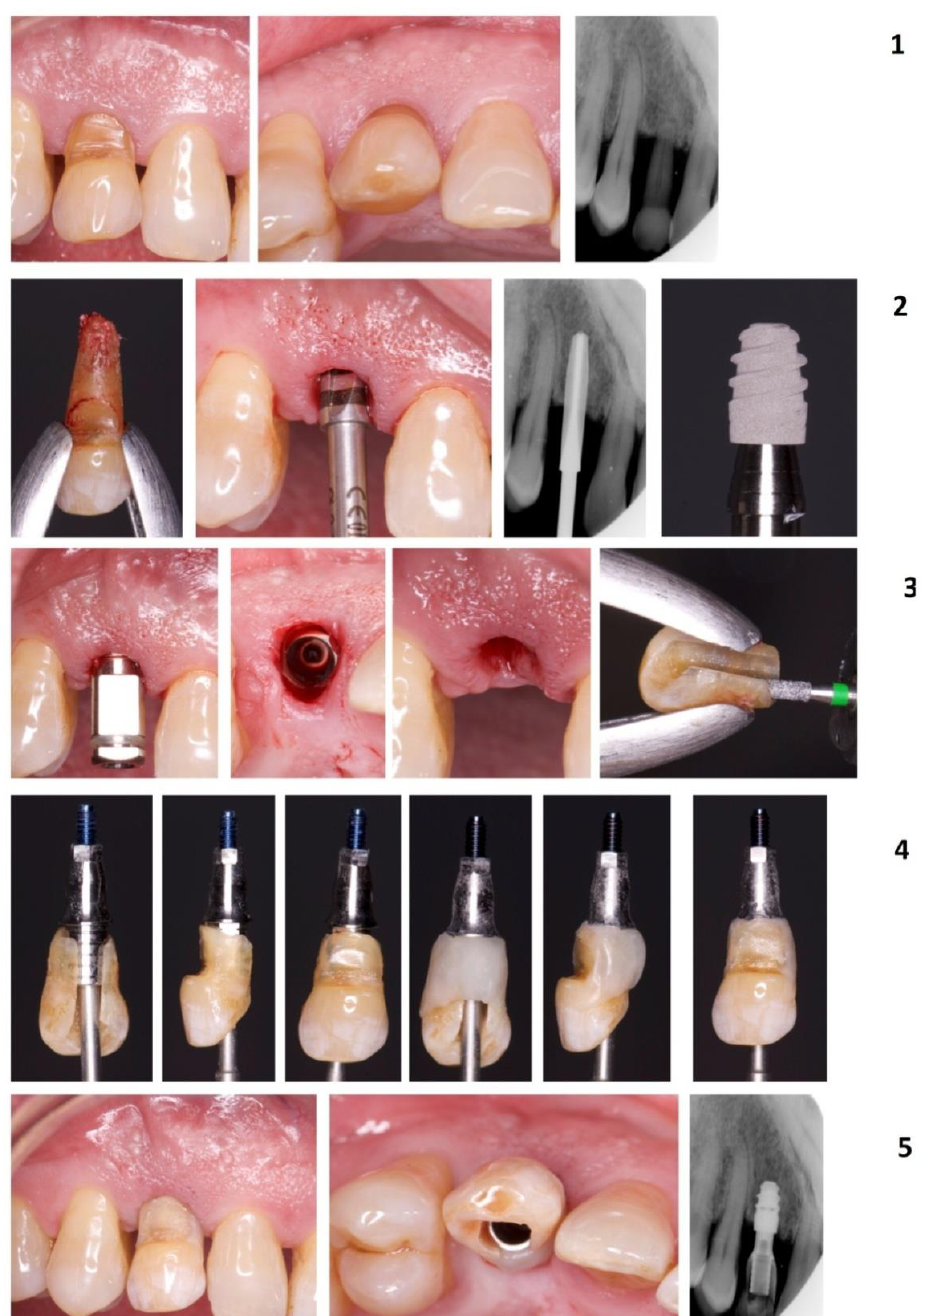
Figure 3. The complete sequence of extraction of the temporal canine and provisionalization phase (Case 1). Temporary canine (images in row 1). Implant placement and implant (Galimplant IPX, size 4 × 6 mm) (images in row 2). The temporary canine crown was adapted and used as a provisional restoration connected to the implant with a titanium screw provisional abutment (rows 3 and 4). Provisional placement and periapical radiograph (row